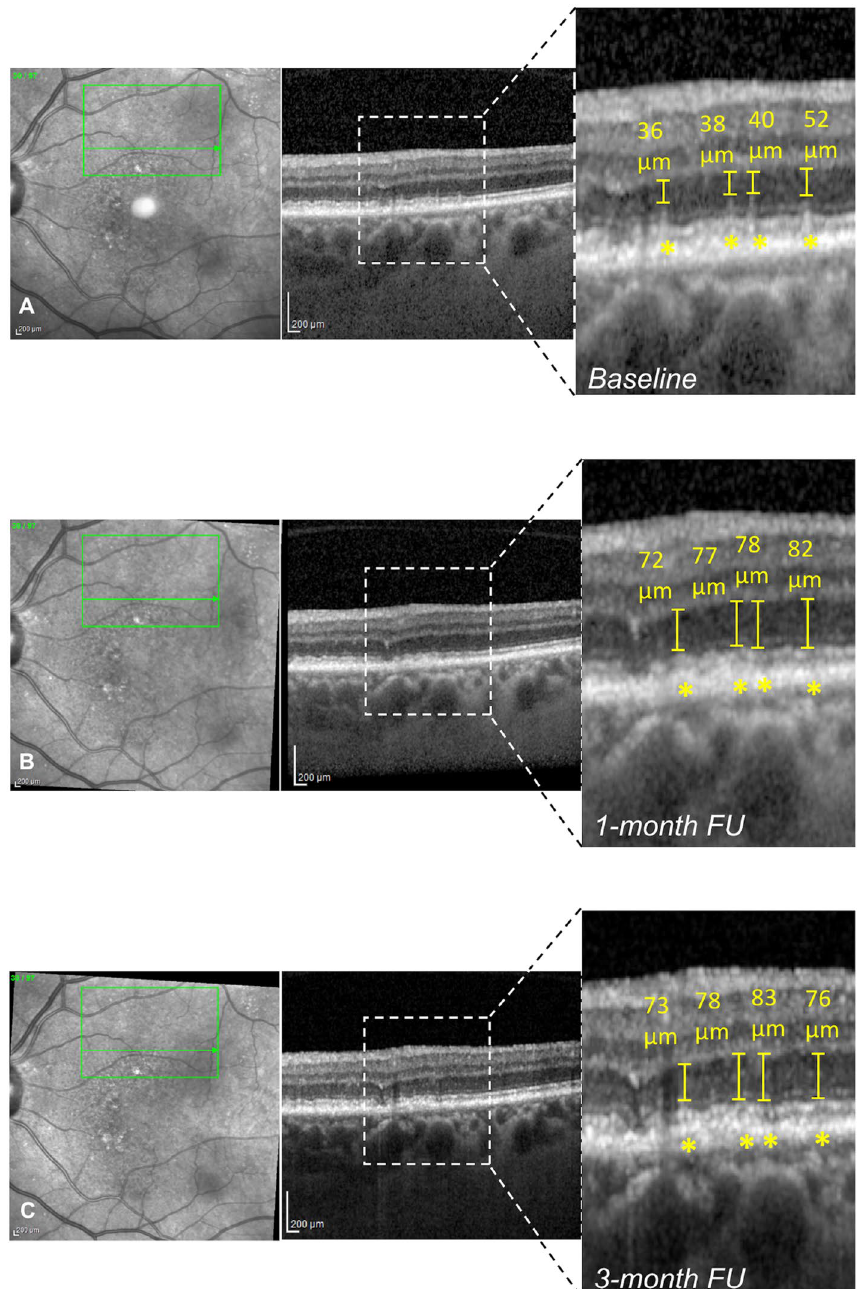
Figure 4. Structural optical coherence tomography (OCT) changes in the morphology of the outer nuclear layer (ONL) before and after subthreshold laser treatment. ( A ) Combined infrared reflectance (IR) and structural OCT showing the presence of 4 reticular pseudodrusen (RPD) in the treated area at the baseline (magnification). ( B , C ) Combined IR and structural OCT showing the partial regression of RPD with increased ONL thickness at 1-month ( B ) and 3-month follow-up ( C )